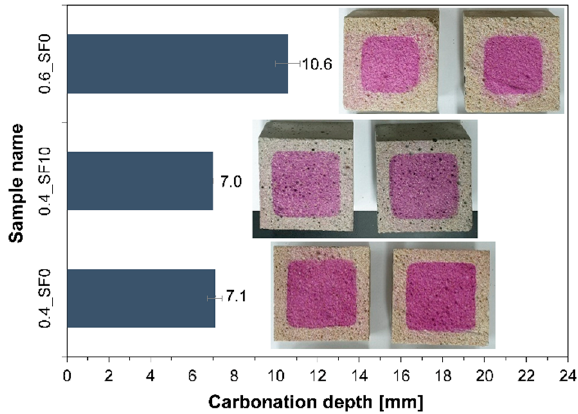
Figure 3. Carbonation depth of air lime mortars at 91 days. The non-carbonated area in the mortar was discolored by phenolphthalein solution.